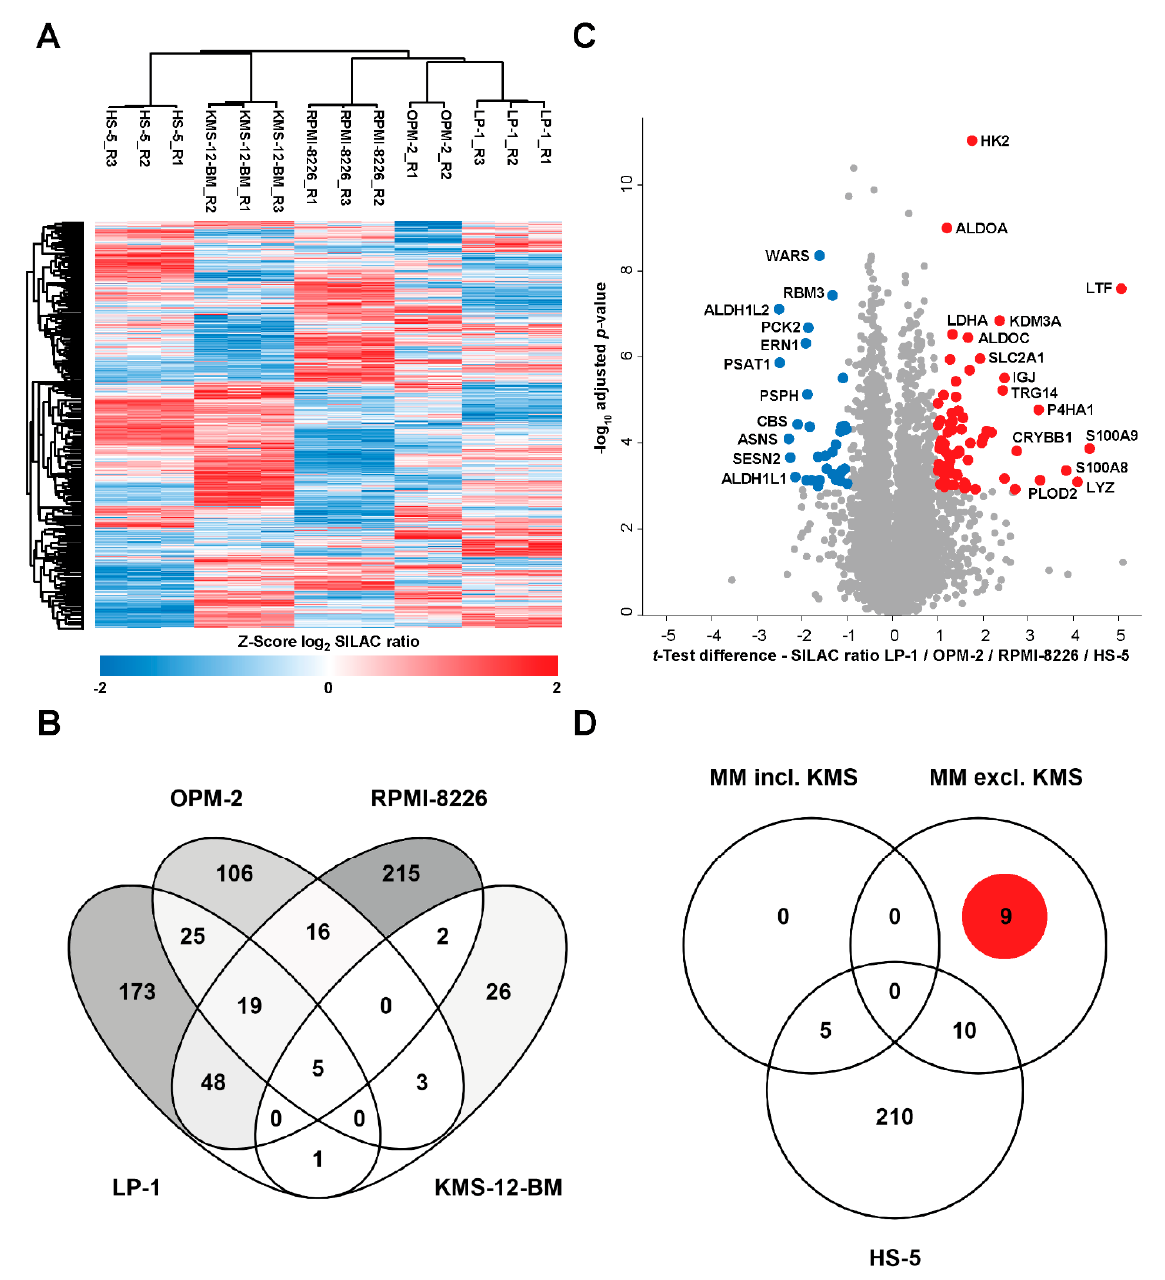
Figure 3. Global proteome profiling of multiple myeloma and stromal cell lines: ( A ) Heatmap of Z-transformed SILAC ratios (chronic hypoxia/normoxia) of protein groups quantified in each LC/MS analysis. Rows and columns are clustered based on the Euclidean distance and average linkage method. ( B ) Venn diagram illustrating the numbers and overlap of proteins regulated under hypoxia for the multiple myeloma cell lines under investigation. Regulated proteins were assigned by filtering for SILAC ratios showing 2-fold up- or down-regulation in at least 2 biological replicate analyses per cell line. ( C ) Volcano plot showing proteins significantly regulated under hypoxic conditions across the multiple myeloma cell lines LP-1, OPM-2, RPMI-8226 and the stromal cell line HS-5. For statistical analysis, one-sample t -test of the log2-transformed SILAC ratios against zero (no change) was conducted and the p -values were adjusted for multiple hypotheses testing (Benjamini-Hochberg FDR < 5%). ( D ) Venn diagram showing the numbers and overlap of regulated proteins between the multiple myeloma cell lines (MM) and the bone marrow stromal cell line HS-5, including and excluding MM cell line KMS-12-BM.